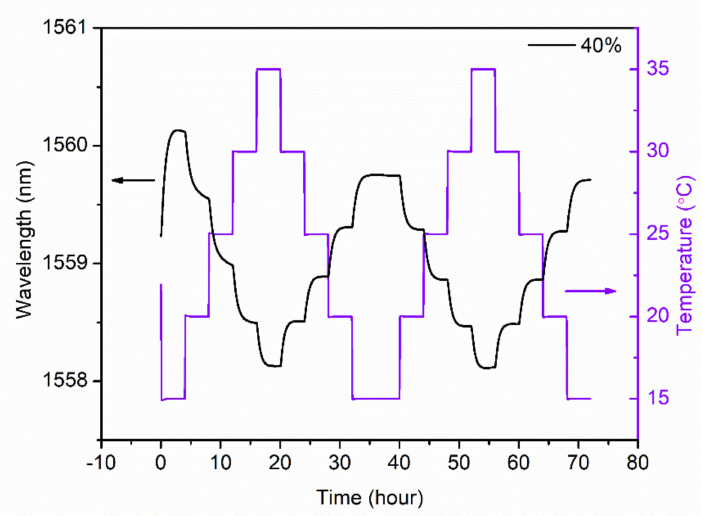
Figure 6. Bragg wavelength shift as a function of temperature in the range 15 ◦ C–35 ◦ C in two cycles for SMC